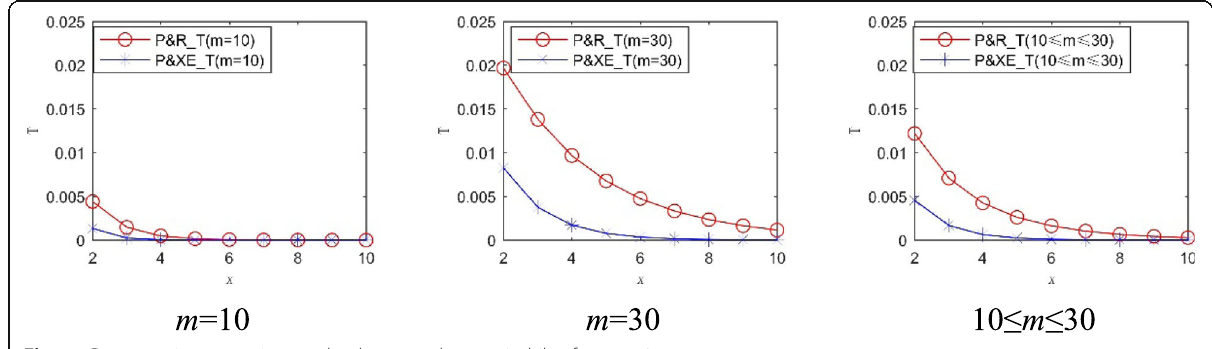
Fig. 15 Data security comparison under the same data survivability for n =